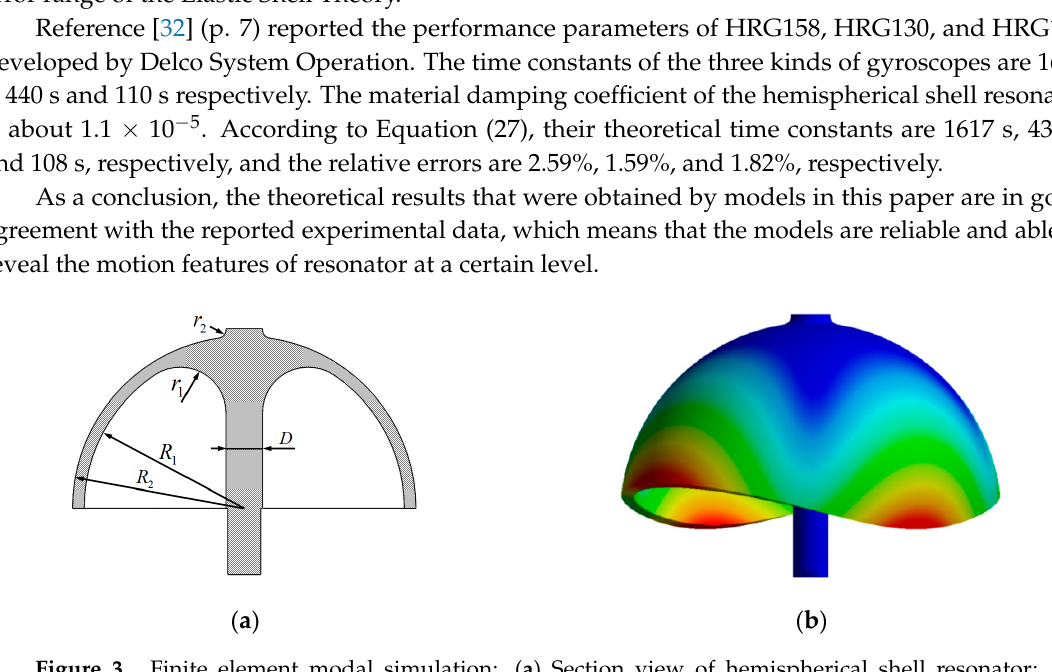
Figure 3. Finite element modal simulation: ( a ) Section view of hemispherical shell resonator; and, ( b ) Finite element modal simulation of hemispherical shell resonator. Table 1. Material and dimension parameters of hemispherical shell resonator.